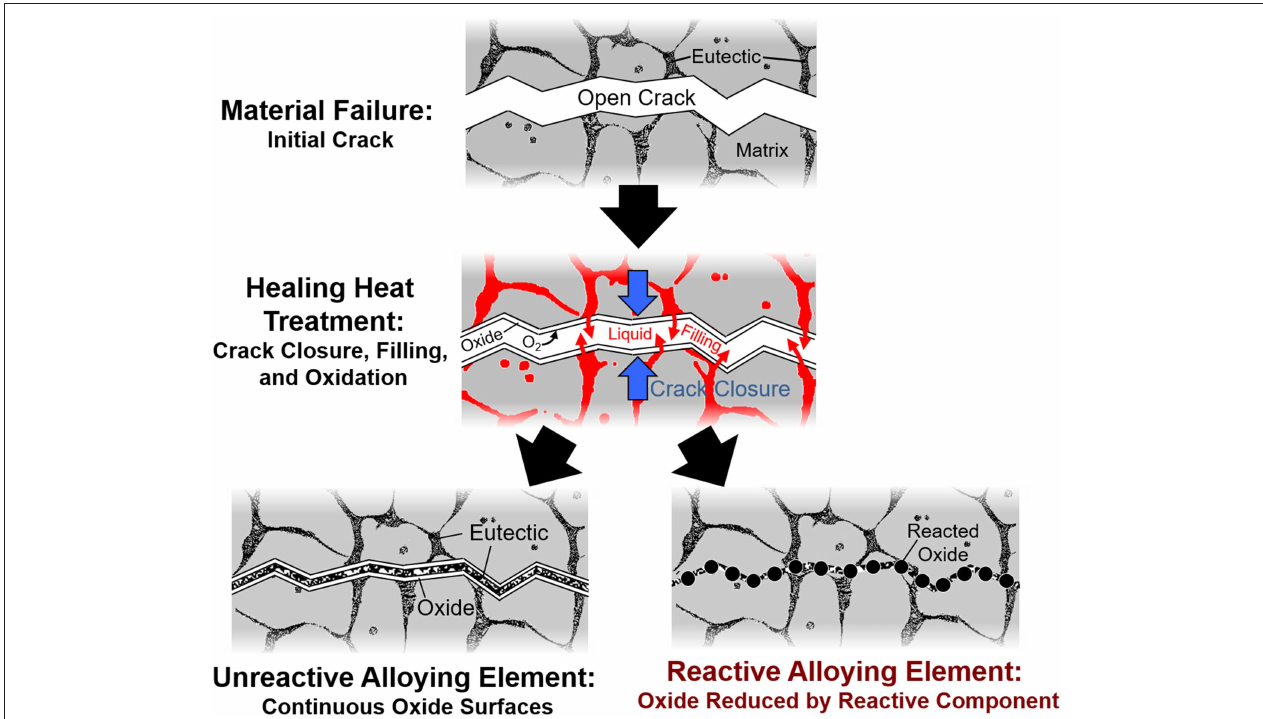
FIGURE 1 | Schematic of crack healing in alloy systems with reactive vs. non-reactive element additions. An alloying element more reactive than the base metal will reduce oxides at the interface, thus creating a strong, thermodynamically-favorable bond.